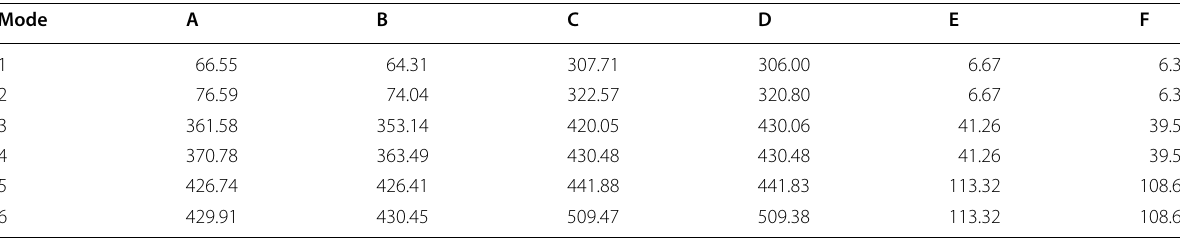
Table 4 Comparison of first six-order frequencies in six cases (Hz) Mode